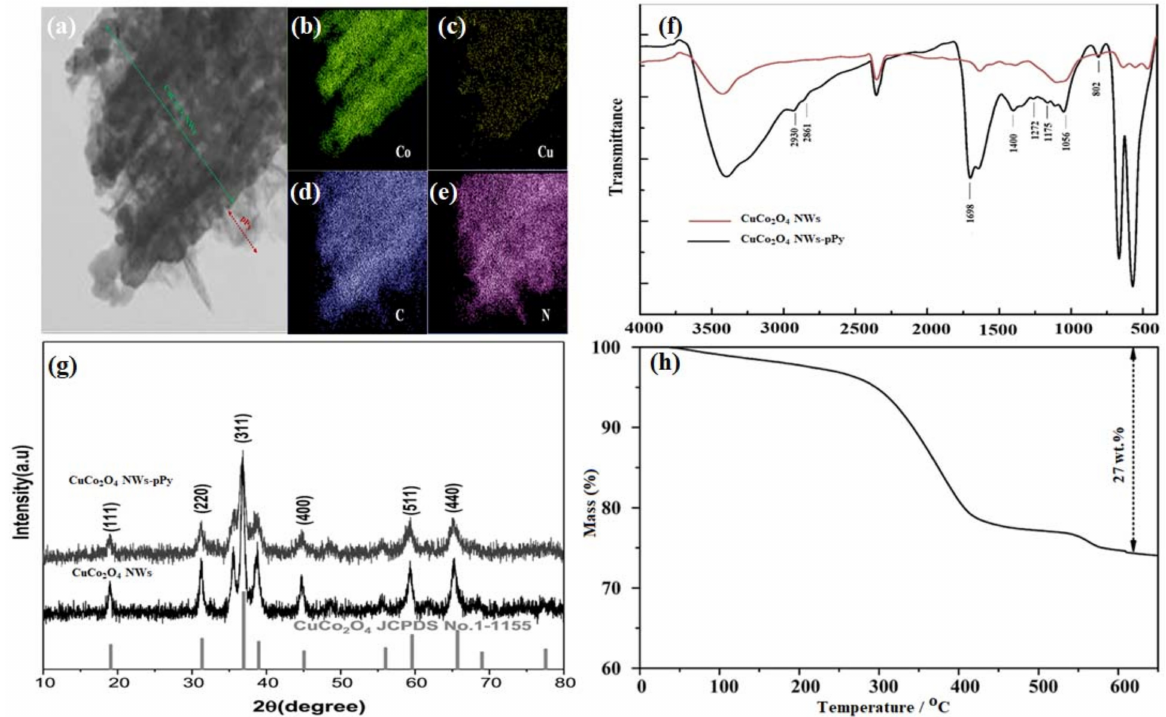
Figure 2. The TEM ( a ) and related TEM/EDS mapping ( b – e ) of CuCo 2 O 4 NWs-pPy. The FTIR spectra ( f ) and XRD patterns ( g ) of as-prepared CuCo 2 O 4 NWs and CuCo 2 O 4 NWs-pPy. ( h ) The TGA curve of as-prepared CuCo 2 O 4